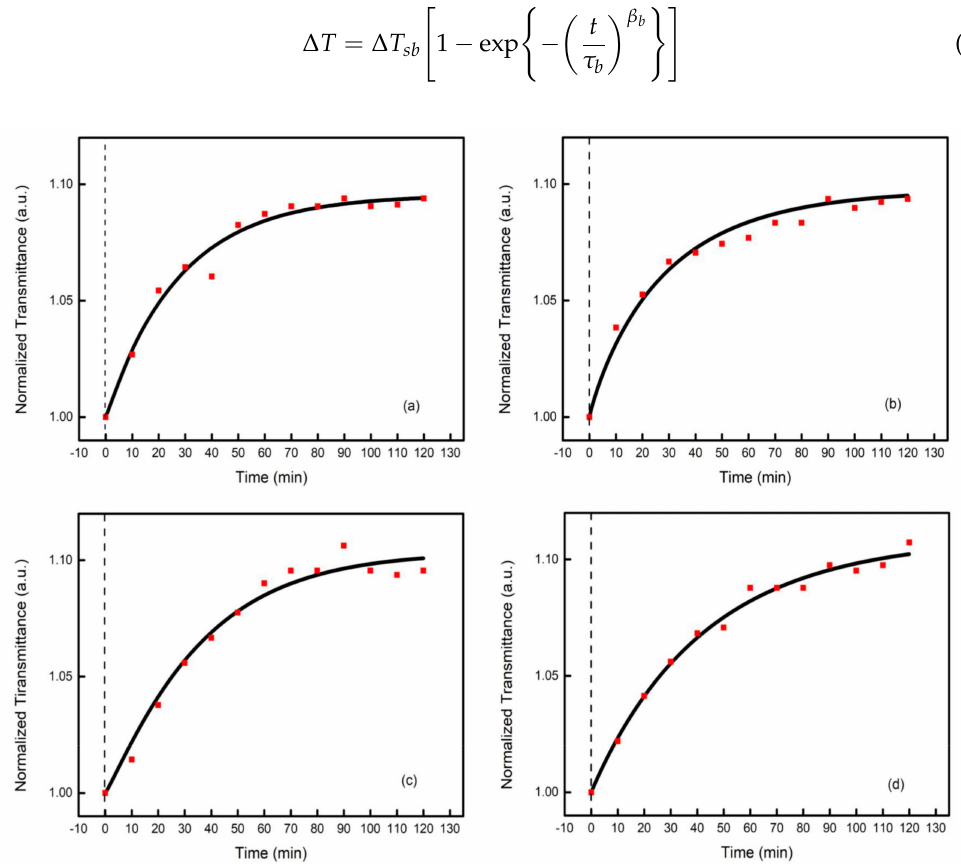
Figure 7. The normalized transmittance of ( a ) Ag 0 , ( b ) Ag 1 , ( c ) Ag 2 , and ( d ) Ag 3 samples under low power density light exposure. The red dots and the black curves correspond to the measured and the fitted